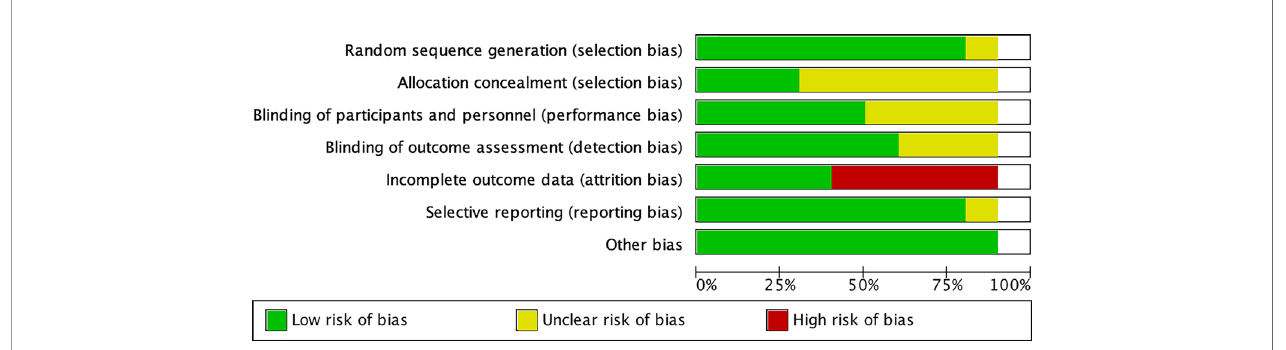
FIGURE 2 | Quality evaluation chart of included studies.